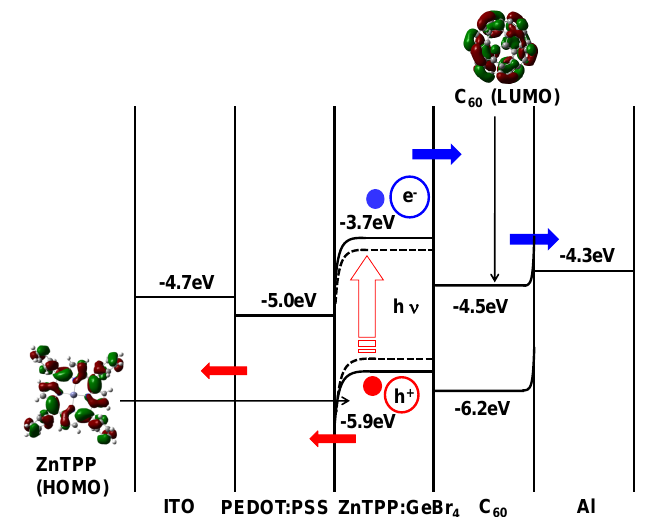
Figure 5. Energy level diagram of the bulk heterojunction solar